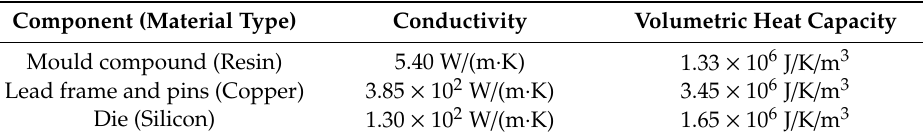
Figure 5. FEM modelling based on the X-Ray image. Table 1. Material thermal properties applied in the